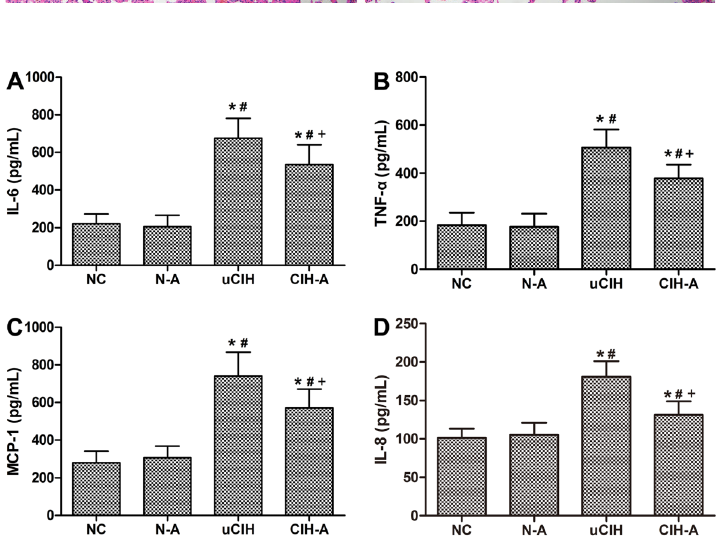
cells compared with controls. CIH-A group showed less in fl ammation and distortion of pulmonary architecture compared with those in uCIH group (Figure 1). Ang-(1 – 7) downregulated the release of proin fl ammatory cytokines in the lungs In the uCIH group, ELISA revealed that the levels of serum TNF- a , IL-6, IL-8 and MCP-1 increased sharply after CIH administration compared with those in the NC and N-A groups (all P o 0.05). In contrast, CIH-A group had signi fi cantly lower levels of TNF- a , IL-6, IL-8 and MCP-1 compared with those of the uCIH group (uCIH vs CIH-A: TNF- a : 506.59 ± 74.75 vs 378.55 ± 57.15 pg/mL, IL-6: 675.25 ± 106.29 vs 535.00 ± 100.82 pg/mL, IL-8: 180.68 ± 20.39 vs 131.05 ± 17.87 pg/mL, MCP-1: 740.25 ± 126.99 vs 571.33 ± 100.82, all P o 0.05; Figure 2).